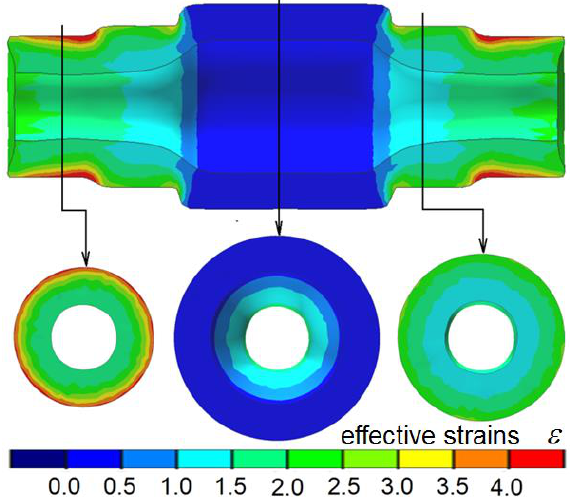
Figure 4. FEM-modeled shape of a stepped gear shaft after Operation 1 and the distribution of effective strains. e ff ective